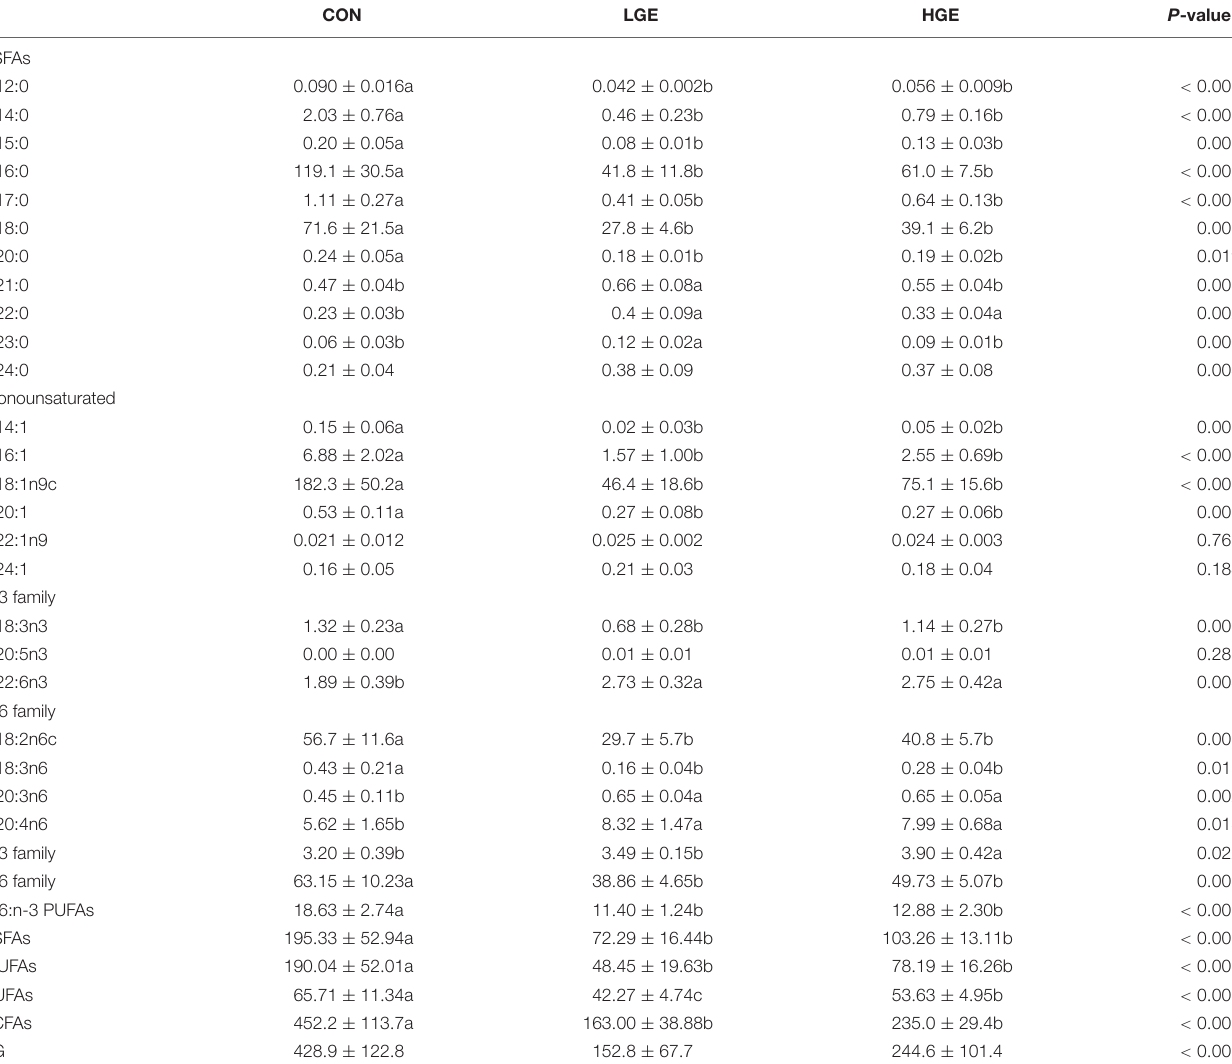
TABLE 8 | Effects of GEN on long-chain fatty acids and triglyceride in the liver of hens. CON LGE HGE P -value